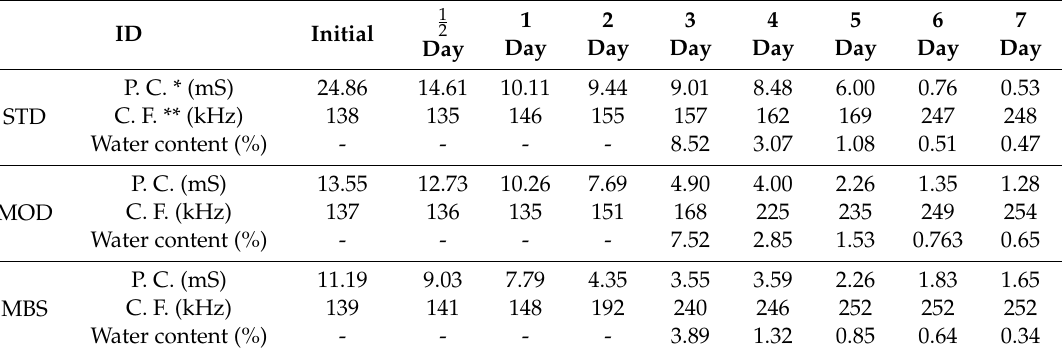
Figure 6. Variations of ( a ) peak conductance, ( b ) corresponding frequency, and ( c ) water content over 7 days. Table 6. Result of the PZT signal measurement.